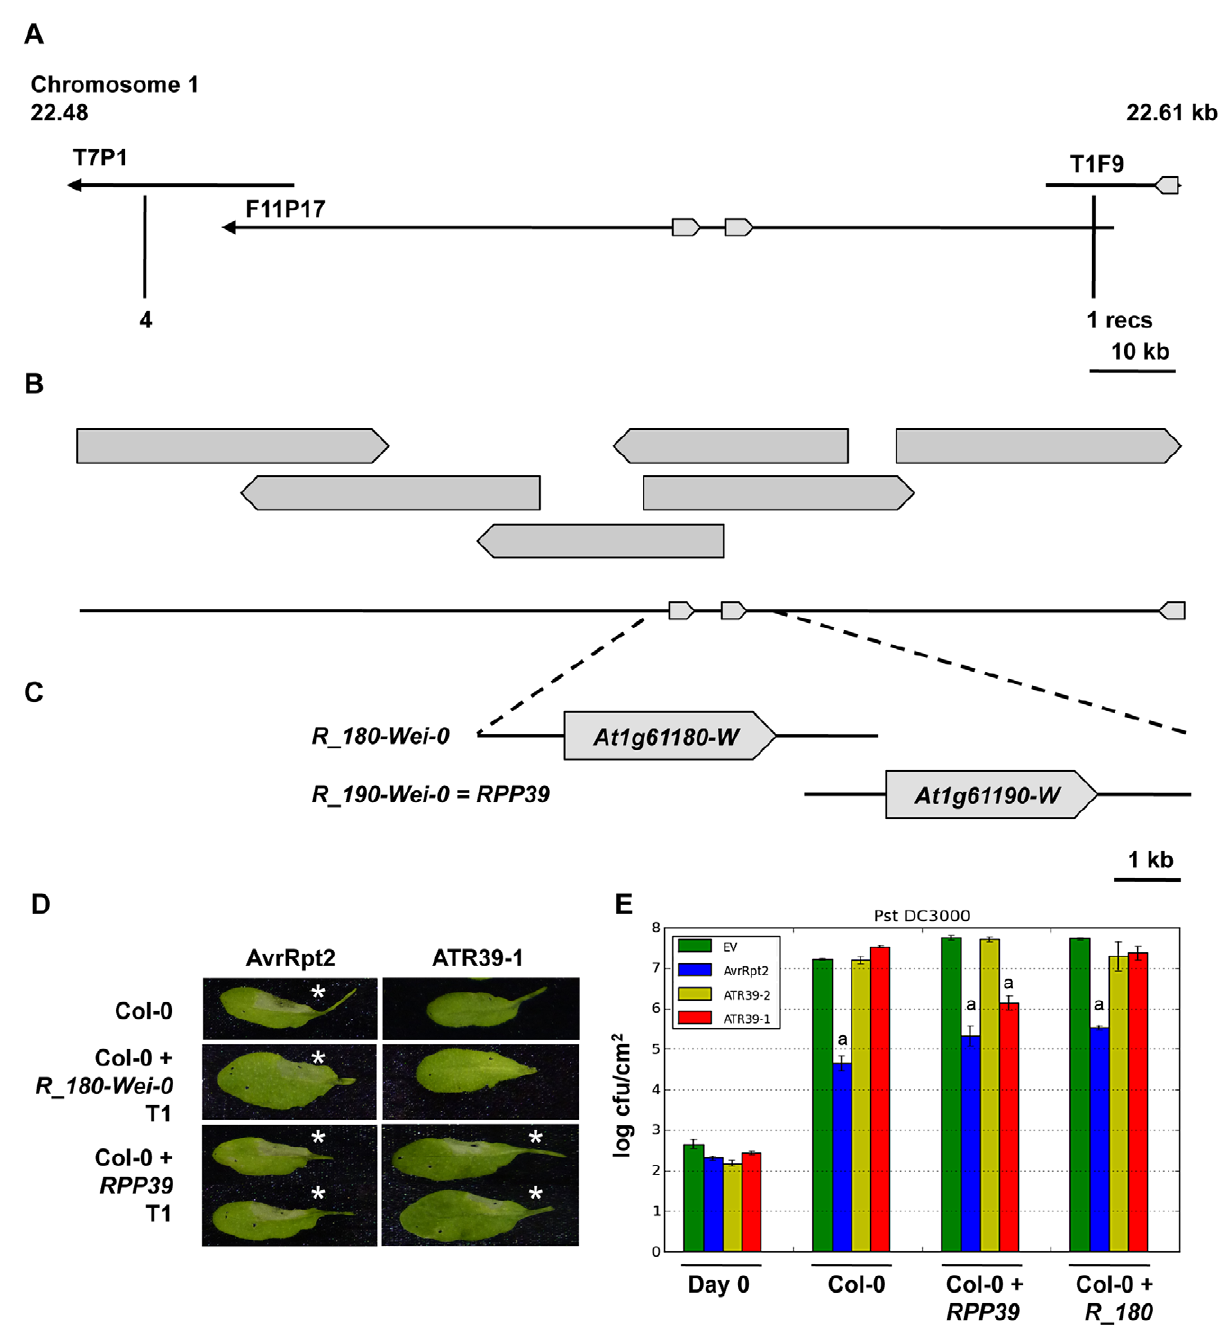
Figure 5. Map-based cloning of RPP39 . A) Map location of RPP39 on Col-0 BAC clones of Chromosome 1. Predicted NBS-LRR R genes are indicated as block arrows. Positions of the last flanking markers and numbers of recombinants are indicated below. B) Wei-0 fosmid contig spanning the 133 kb locus containing RPP39 . C) Genomic clones of the R genes at the RPP39 locus used in functional analysis in transgenic Col-0 Arabidopsis . D) HR induced by ATR39-1 and AvrRpt2 in transgenic Arabidopsis Col-0 T1 transformed with the R gene candidates in C. The lower half of each leaf was inoculated with an empty vector control. Pictures were taken 24 hpi. Stars highlight positive HR. E) Pst DC3000 growth assay on select T2 transgenics containing R gene candidates. Significant differences as determined by Student’s t-test are indicated by small letters (P , 0.0003). Experiments were repeated at least twice with similar results.